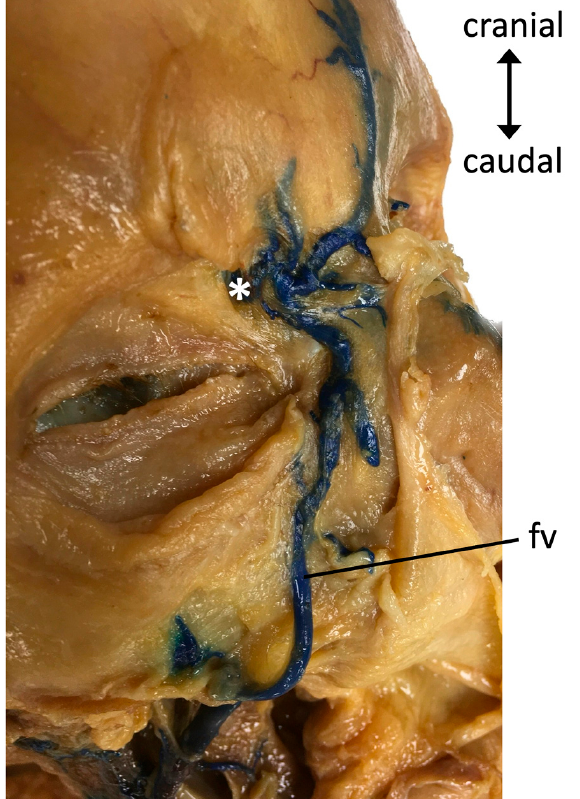
Figure 3. The right side of a male specimen’s face. The facial vein (fv) was injected with blue latex and carefully dissected. The anastomosis between the facial vein and the superior ophthalmic vein (*) can be seen.